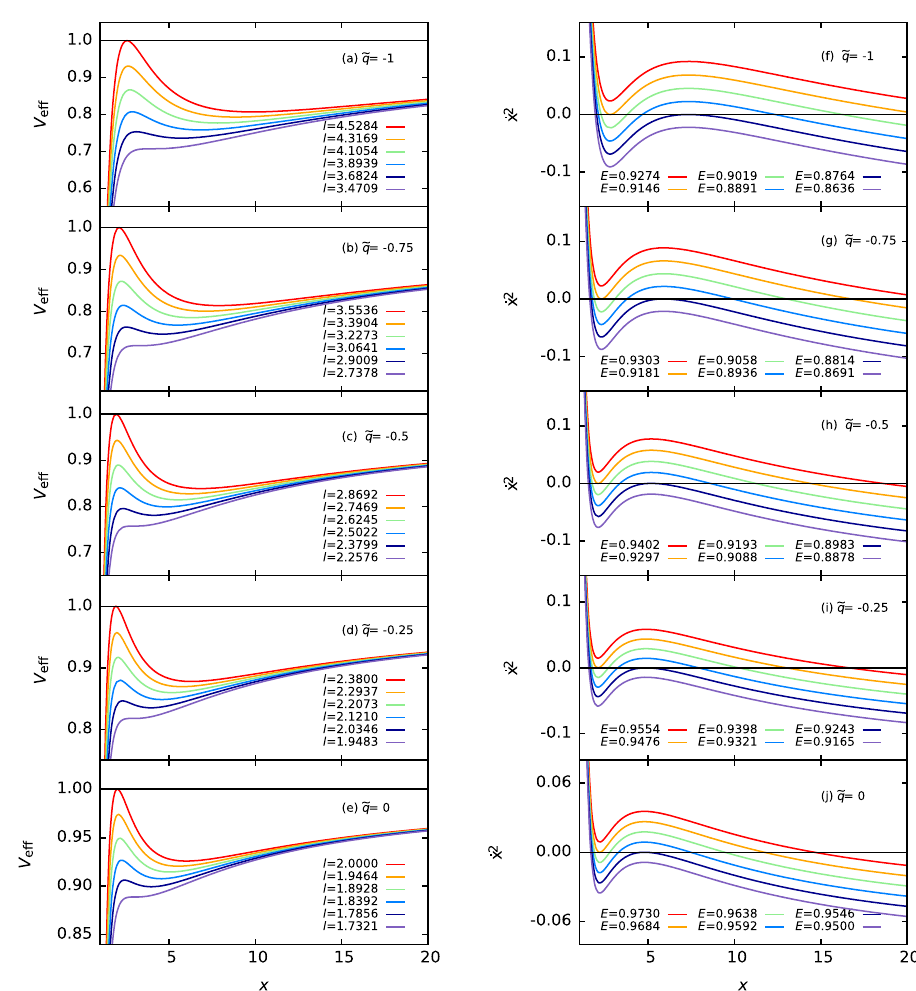
Fig. 4 The effective potential V eff and radial motion ˙ x 2 vary with x for a neutral timelike particle around the hairy black hole. Left column: V eff varies with different values ˜ q and l . Right column: ˙ x 2 varies with different values ˜ q and